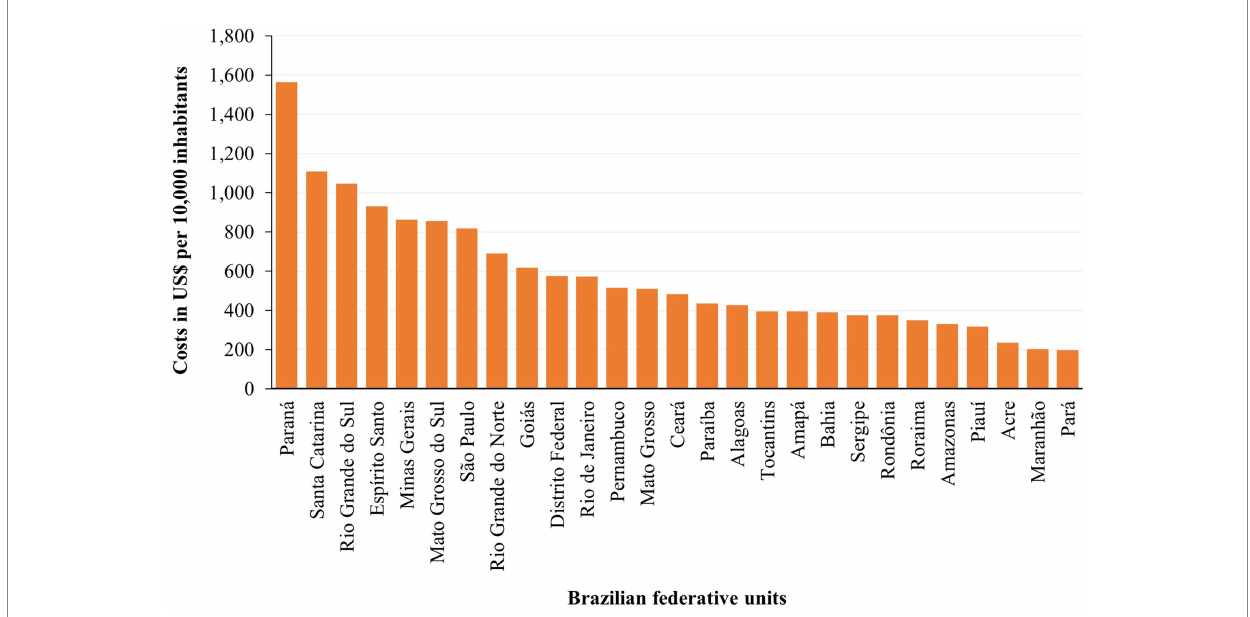
FIGURE 4 Costs of hospitalizations and outpatient procedures per 10,000 inhabitants for chronic noncommunicable diseases attributable to a diet rich in processed meat to the Unified Health System in the Brazilian federative units in